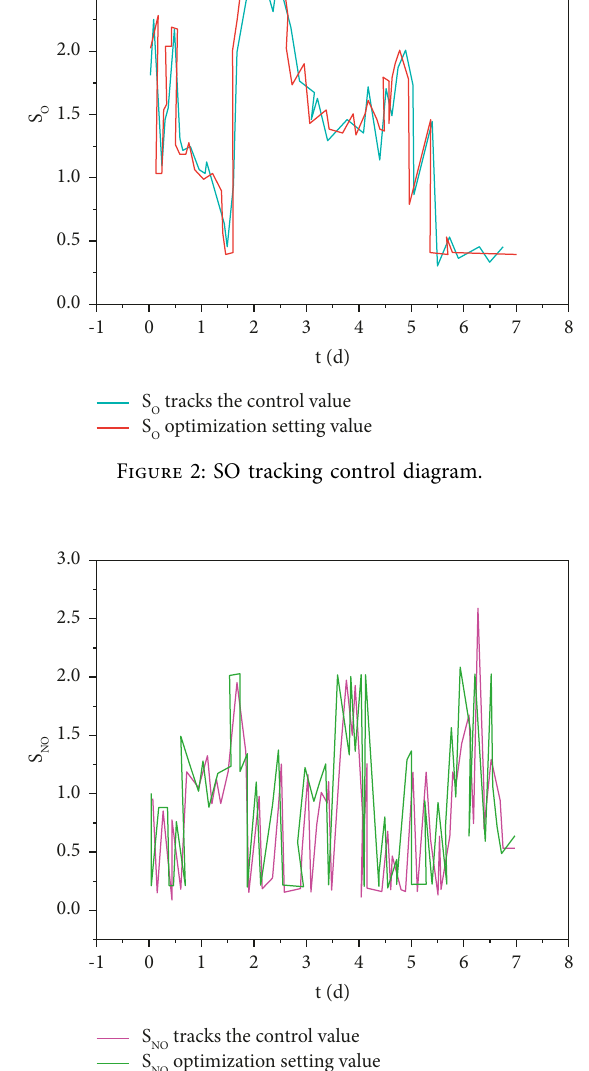
Figure 3: SNO tracking control diagram.